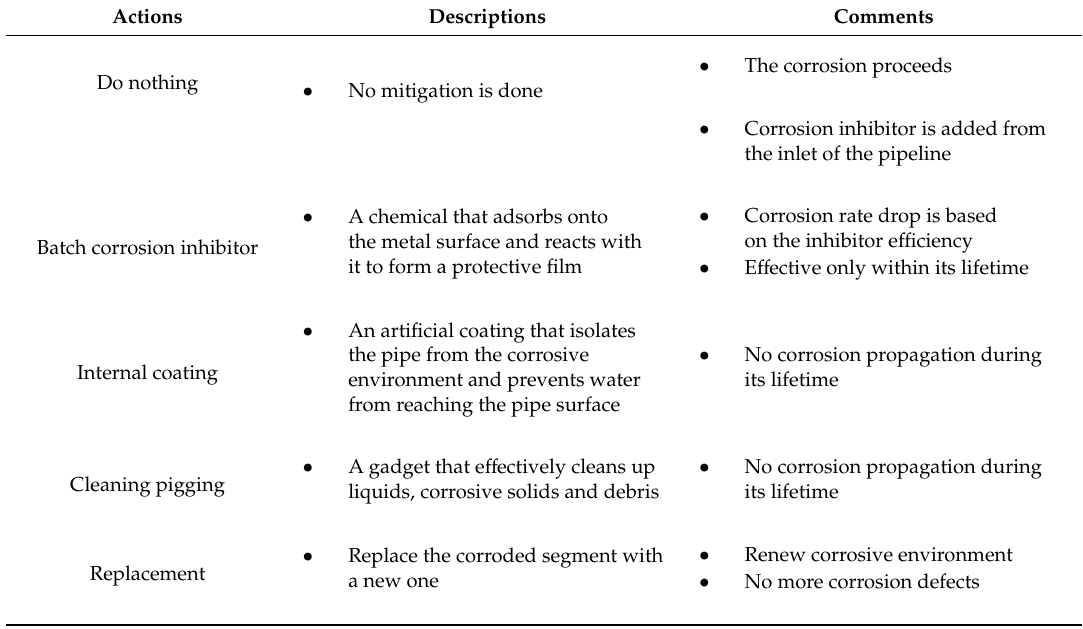
Table 2. The maintenance scheduler set of maintenance